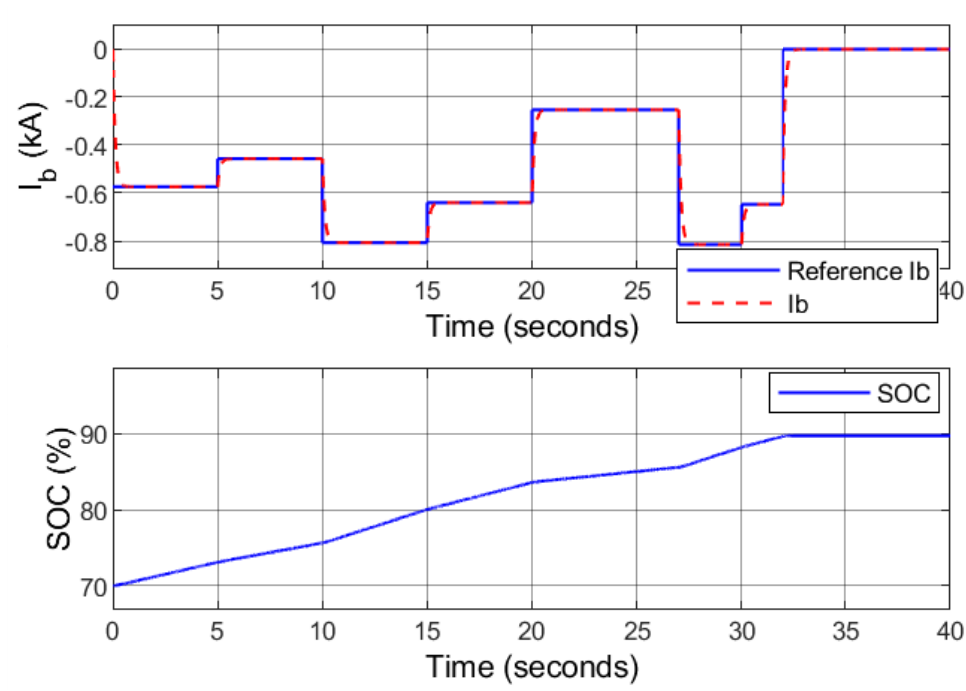
Figure 14. Scenario 3: tracking performance of the battery current and the corresponding SOC.